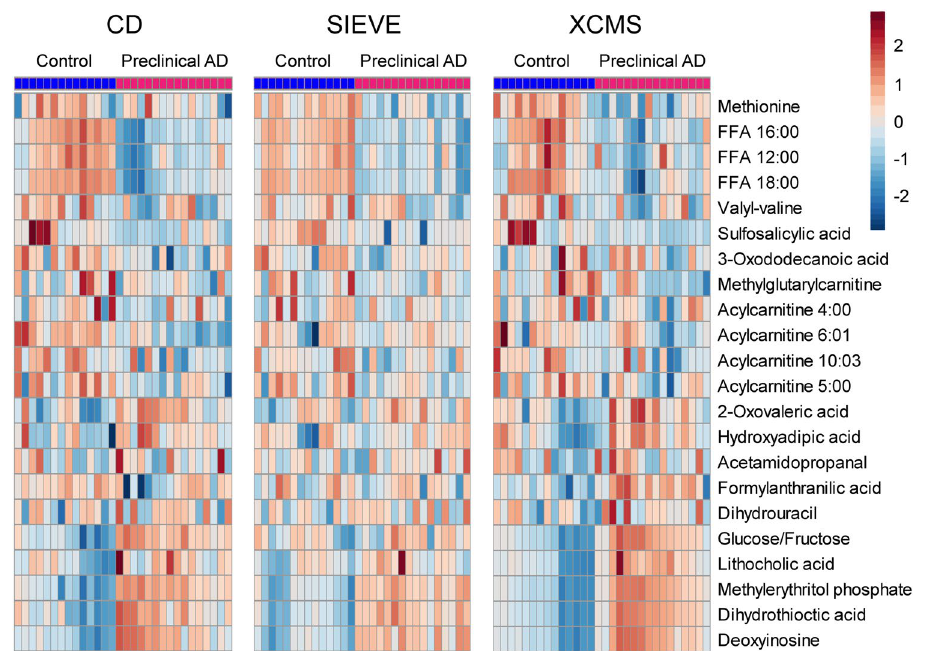
Figure 4. Heatmaps of representative candidate biomarkers among shared metabolites from three software packages. The data was log transformed and auto-scaled.